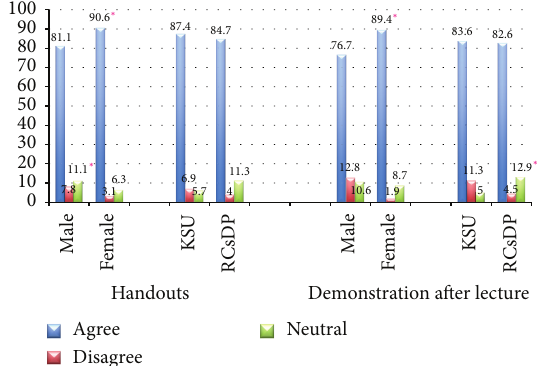
Figure 6: Percentage of dental students’ preferences regarding handouts and demonstration after the lecture ( ∗ 𝑃 < 0.05